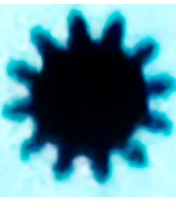
Figure 10. The relationship between output and time. Line 1: Diagram of punch impact force versus time; Line 2: Diagram of punch displacement versus time; Line 3: Diagram of die adjusting displacement with time.